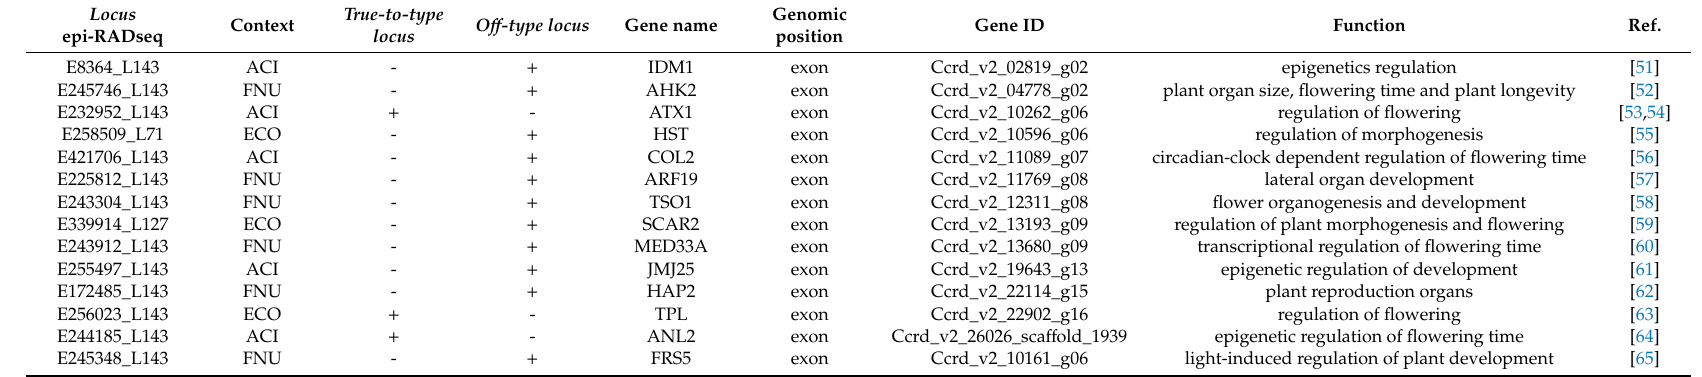
Table 1. Features belonging to a subset of di ff erentially methylated loci. Loci are characterized by context, hypo-methylation (‘ − ‘) or hyper-methylation (‘ + ’), genomic position, gene ID, and putative